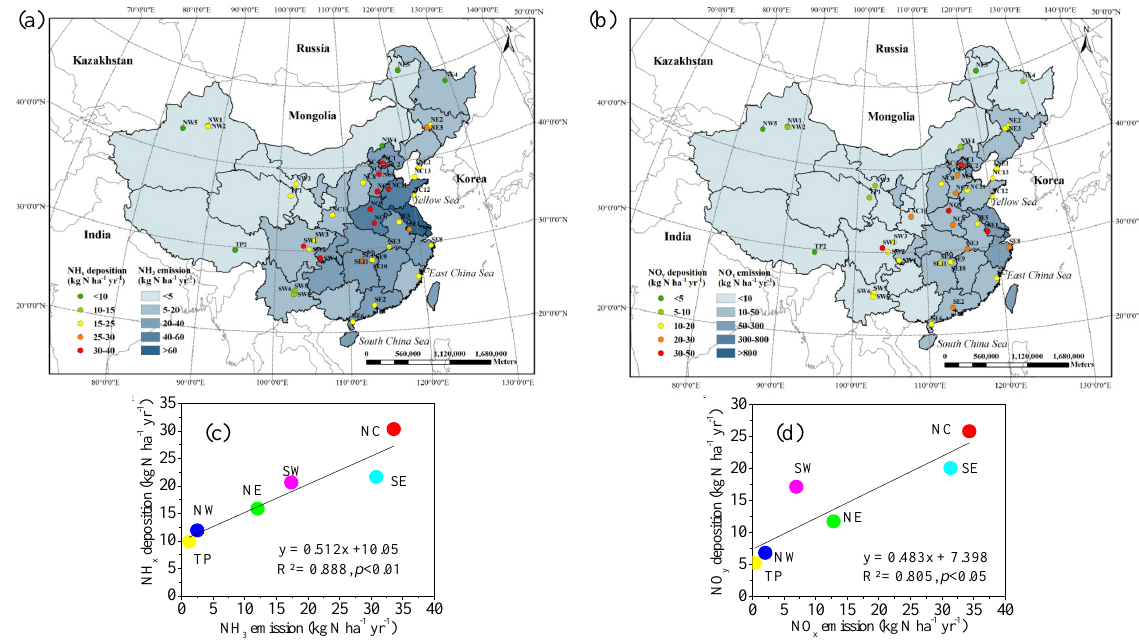
Figure 9. Spatial variation of atmospheric N deposition flux with emission distribution in China: (a) NH 3 emission vs. NH x deposition; (b) NO x emission vs. NO y deposition; (c) relationship of NH x deposition vs. NH 3 emission; (d) relationship of NO y deposition vs. NO x